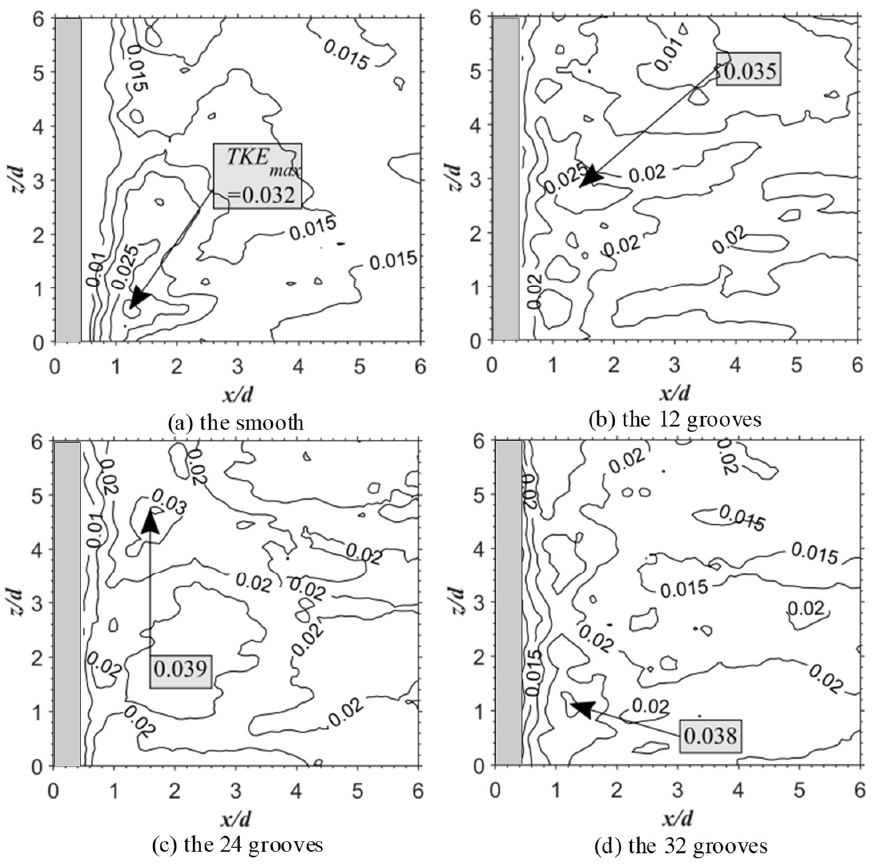
Figure 10. Contours of the turbulent kinetic energy in the ( x, z )-plane.